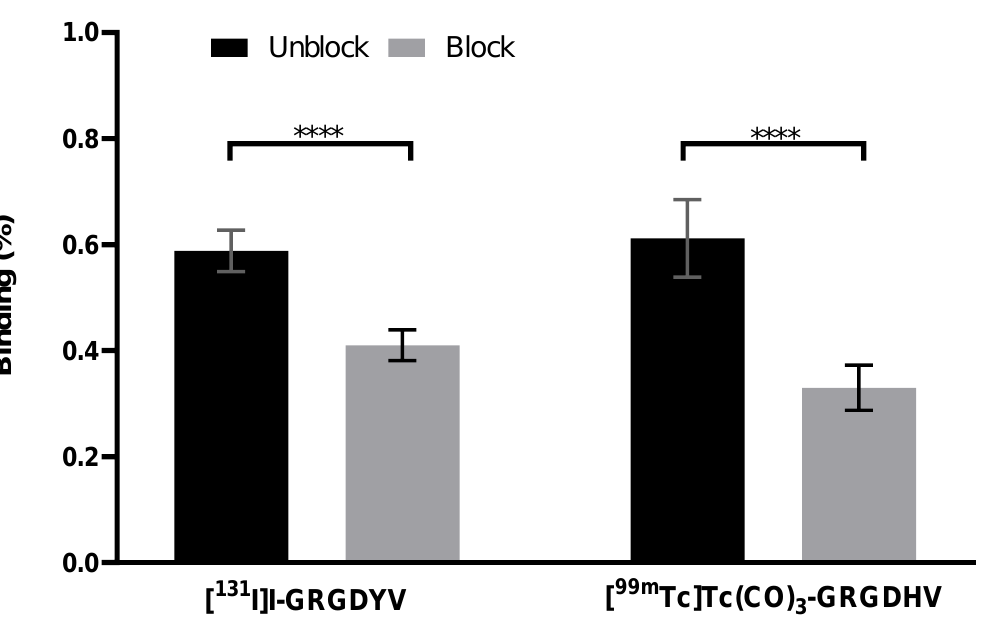
Figure 8. Specific binding of radiolabeled peptides to C6 cells. Data are expressed as ‘mean ± SD’. p < 0.0001 (****).